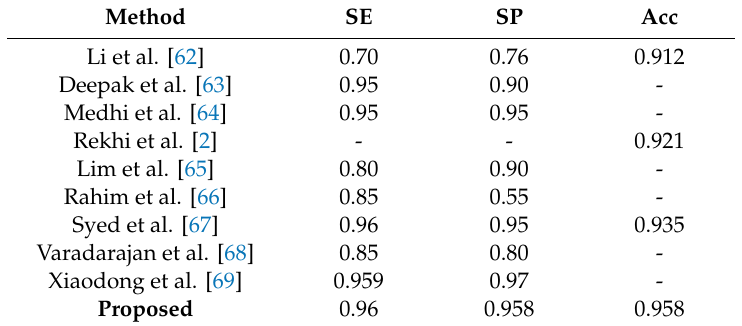
Table 8. Performance comparison against DME detection methods over MESSIDOR dataset.